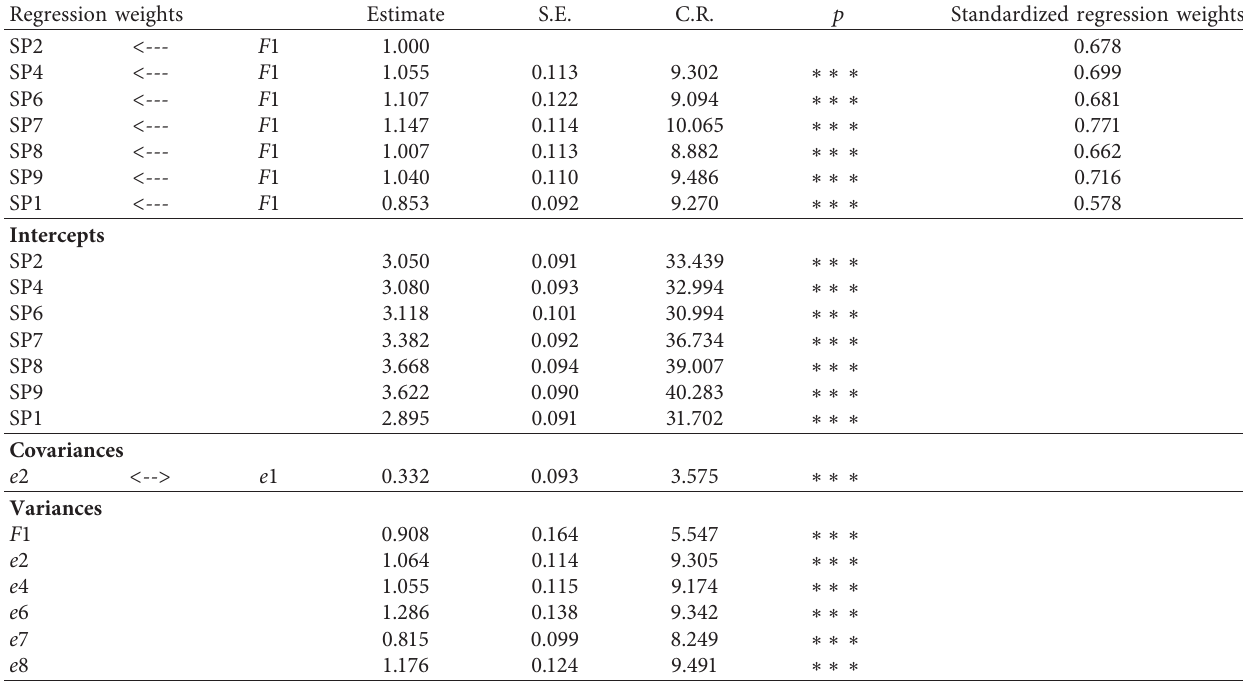
Table 2: Maximum likelihood